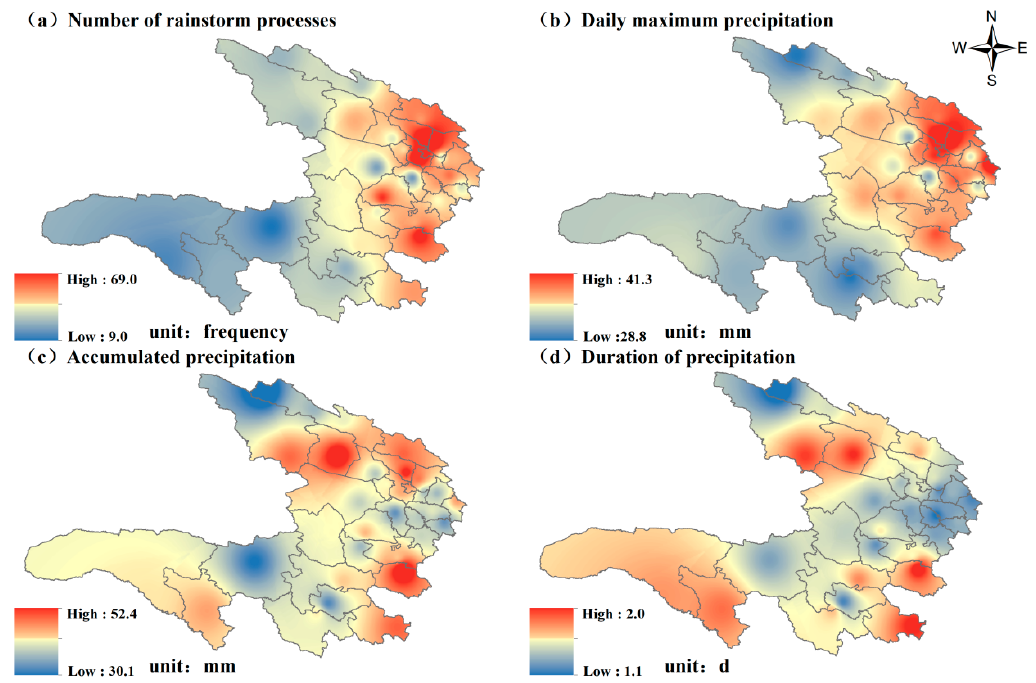
Figure 5. Spatial distribution of the number of heavy precipitation processes ( a ), daily maximum precipitation ( b ), accumulated precipitation ( c ), and duration of precipitation ( d ) in the upstream of Yellow River Basin from 1961 to 2021.